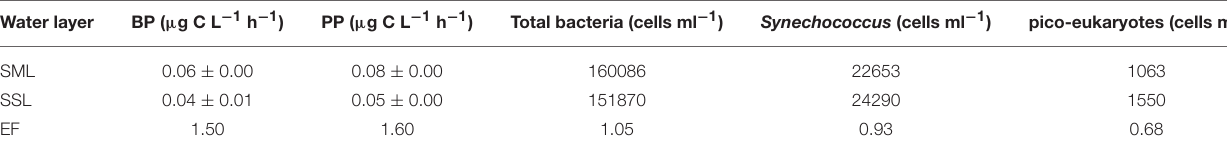
TABLE 2 | Initial biological characteristics of the SML and SSL prior aerosol addition (T0). Water layer